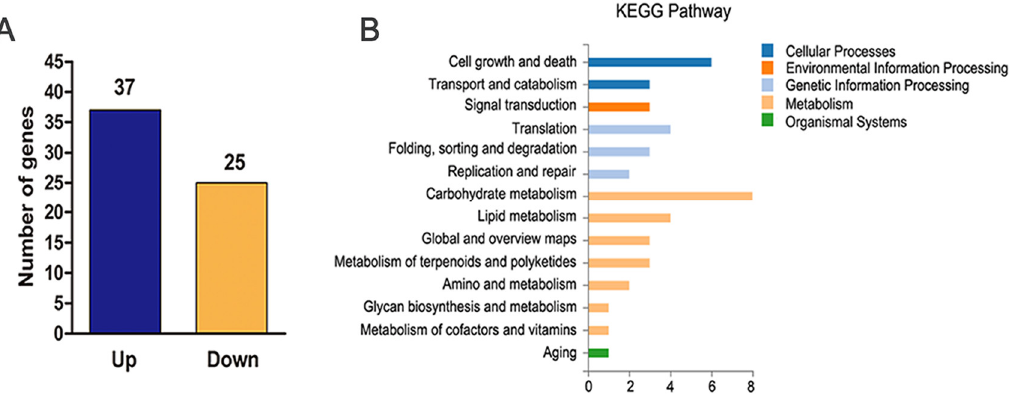
Figure 9. Analyses of differentially expressed genes. ( A ) Numbers of differentially expressed genes. ( B ) GO annotation of differentially expressed genes.